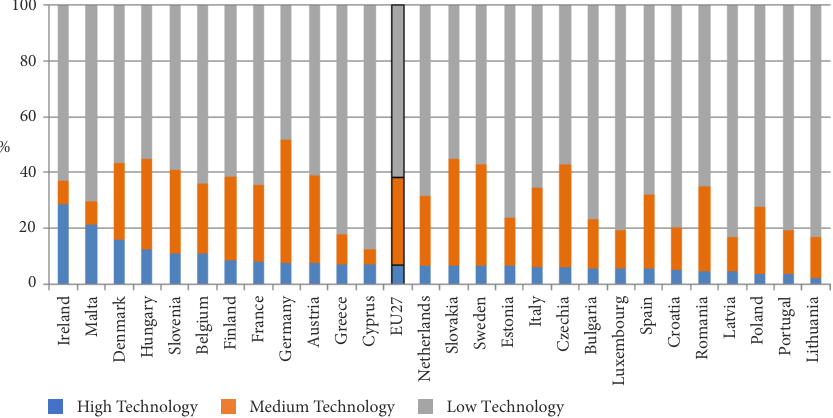
Figure 4. Share of employment based on technology sectors in total employment in manufacturing in EU in 2020 (source: author computation based on Eurostat,